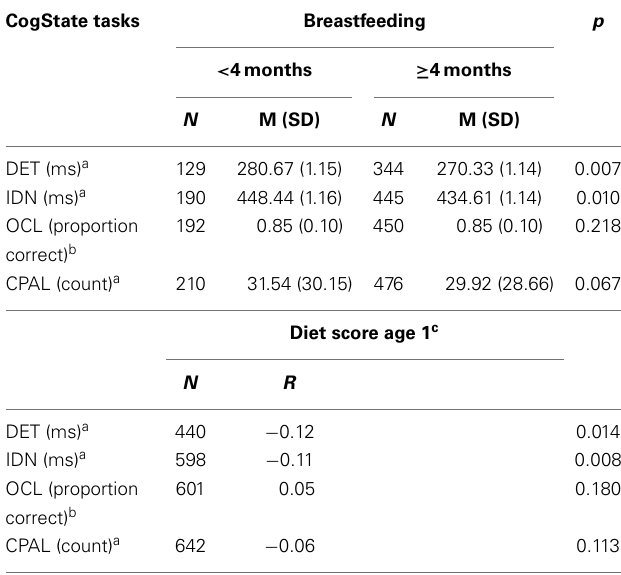
Table 1 | Descriptive statistical data for participants in CogState at Table 2 | Unadjusted mean scores (and SD) for each cognitive measure according to breastfeeding category, and Pearson’s correlation between diet score at age one and each cognitive measure